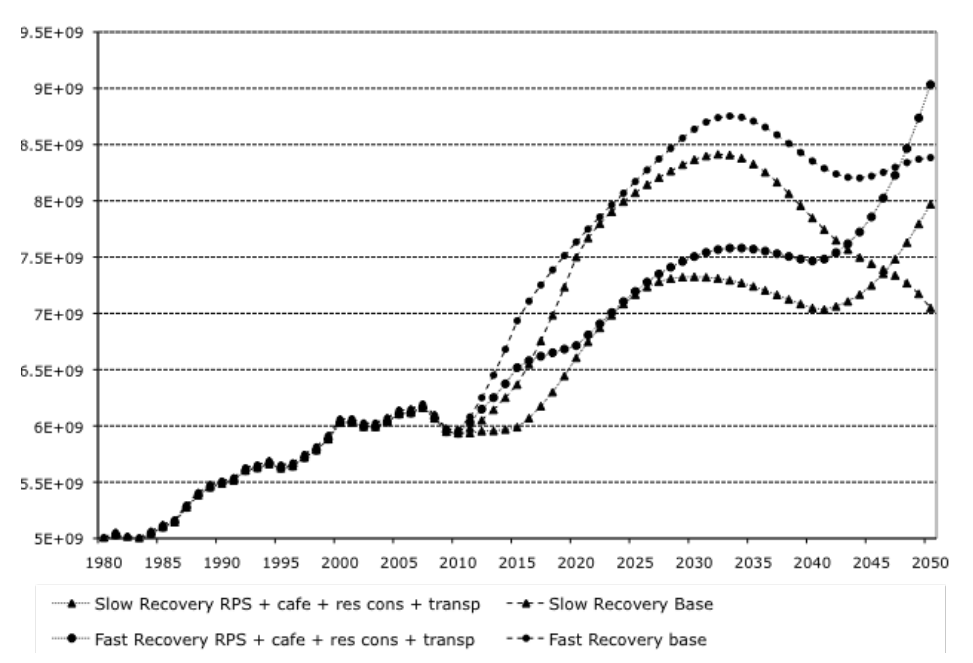
Figure 3. Results of the simulation of T21-USA, GHG emissions (Ton/year).